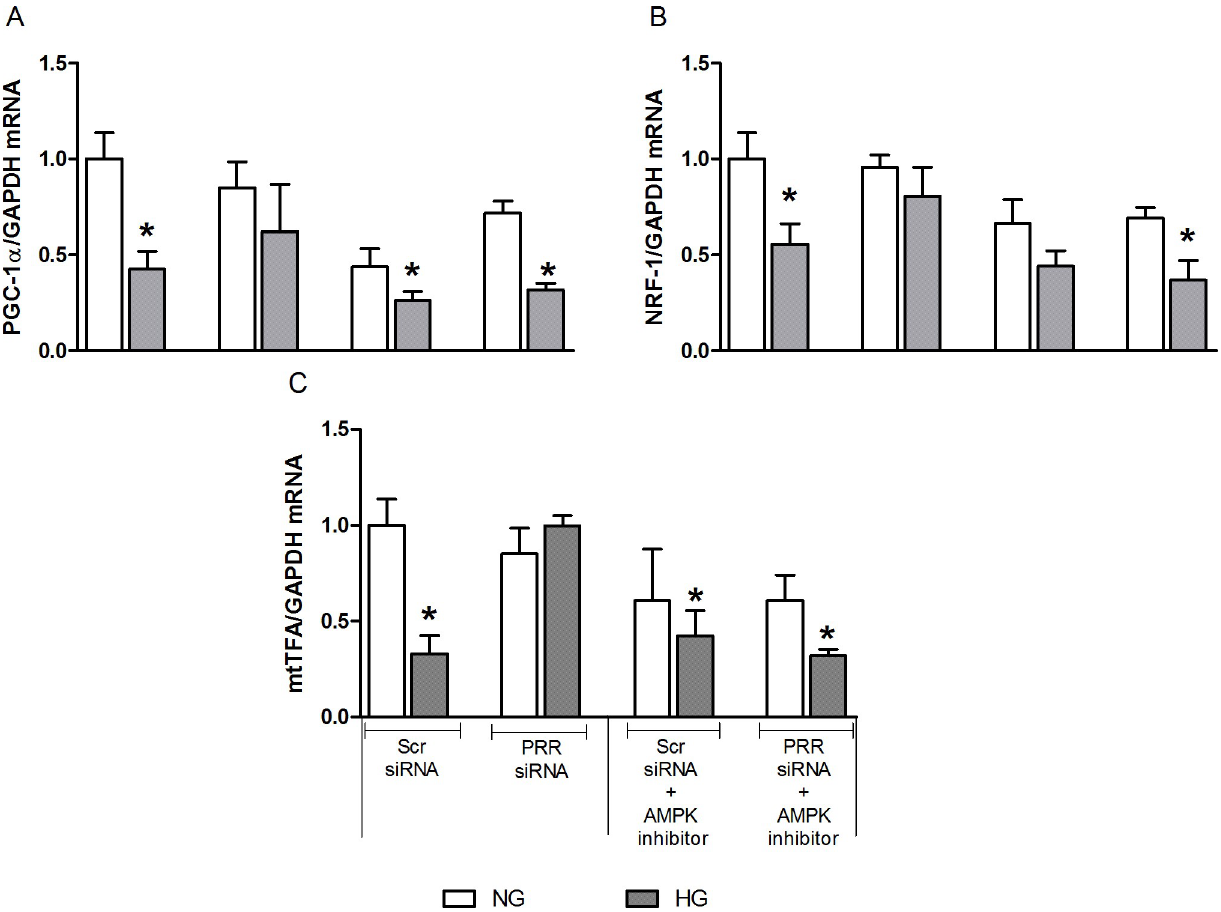
Fig 7. Effects of combined treatment of PRR siRNA and AMPK inhibitor on the expression of PGC-1 α , NRF-1, and mtTFA in mRMCs. Effect of AMPK receptor blockade or in combination with (pro)renin receptor (PRR) siRNA on the expression of PGC-1 α , NRF-1 and mtTFA mRNA (A-C) in response to NG or HG in mRMCs. Data are mean ± SEM. � P < 0.05 vs. NG + scramble (Scr) siRNA. n = 8 each